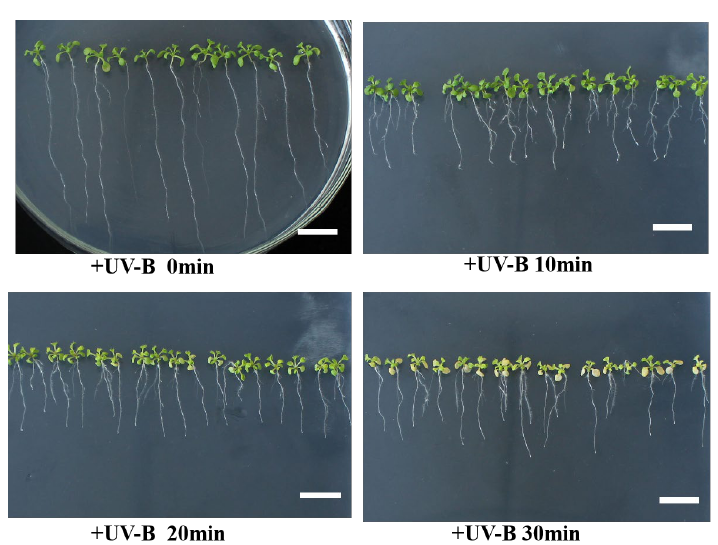
Figure A1. Phenotype screening of Col-0 A. thaliana seedlings responding to different duration of UV-B radiation to determine that 30 min of 90 mJ cm − 2 of UV-B radiation was selected for this study. Scale bars represent 1 cm.